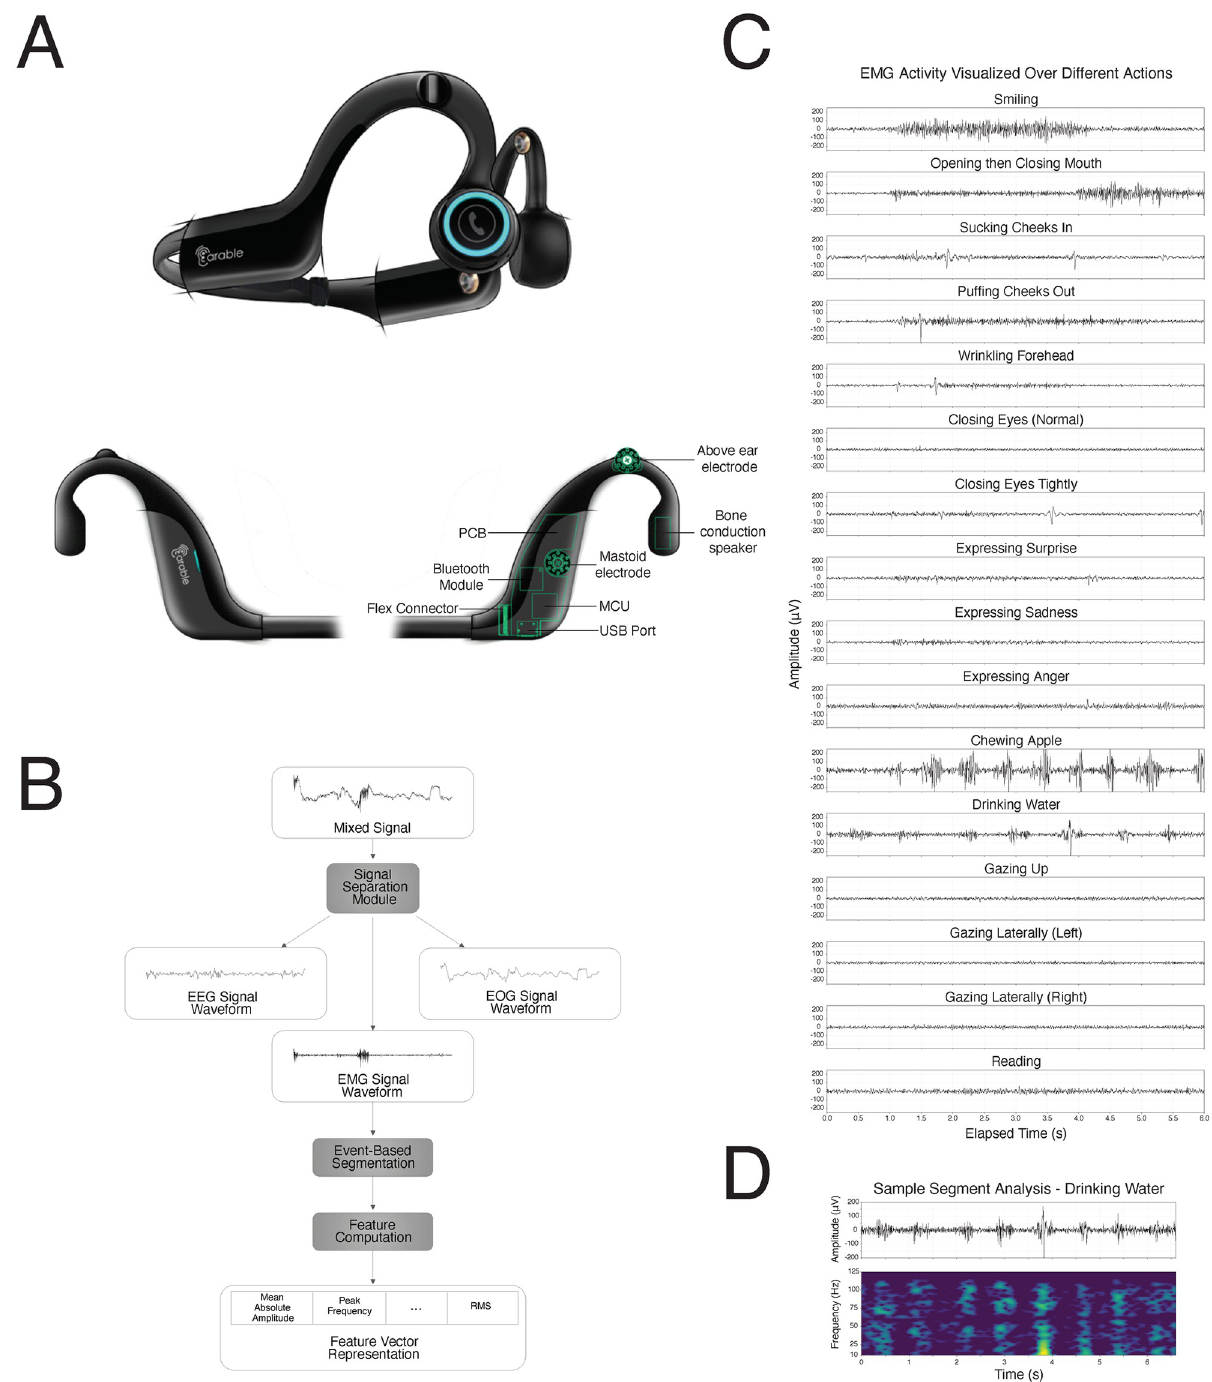
Fig 1. A. A schematic of the Earable device used in this pilot study. The left and right earpiece components, which sit over the ears of the participant, house the primary electrical components of the device and are connected by a flexible circuit within a connecting band that allows the device to be worn comfortably by patients with varying head shapes and sizes. The microcontroller unit (MCU) enables data acquisition, signal processing, and on- device data processing. A Bluetooth module is incorporated for data streaming directly to a local computer or mobile phone. Multi-channel, electrophysiological data is acquired through dry electrodes that contact the participant’s scalp above each over and over each mastoid process. Although not directly applicable to this pilot study, music and audio-based stimulation and therapy is made available to the patient via bone- conduction speakers. B. Signal Processing and feature extraction pipeline used in this study. A signal separation module is applied to the mixed signal derived from the Earable device, to separate the EEG, EMG, and EOG waves into their component parts. These signals are then subject to an event-